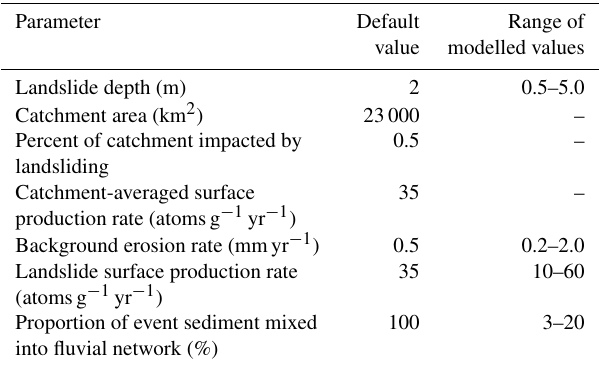
Table 3. Default and range of parameter values used in numerical